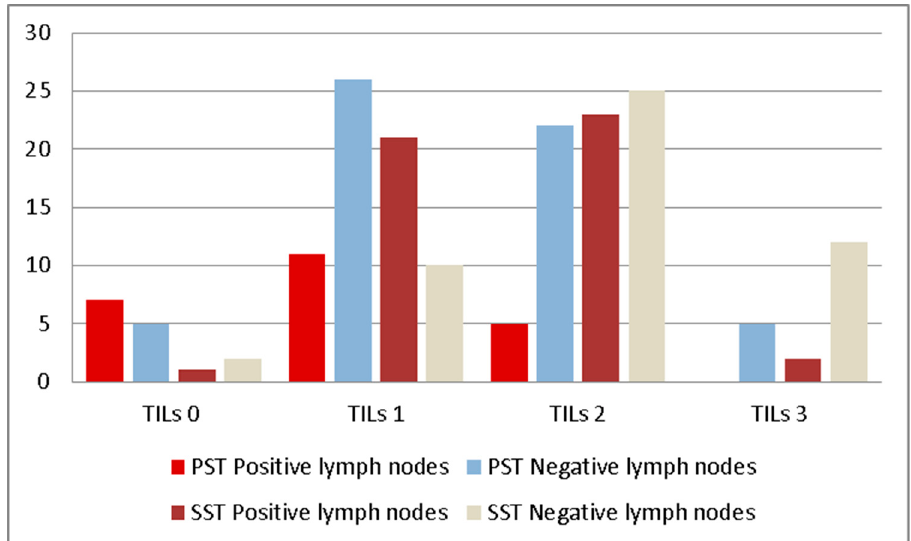
Figure 1. Lymph nodes status according to TILs subgroups .